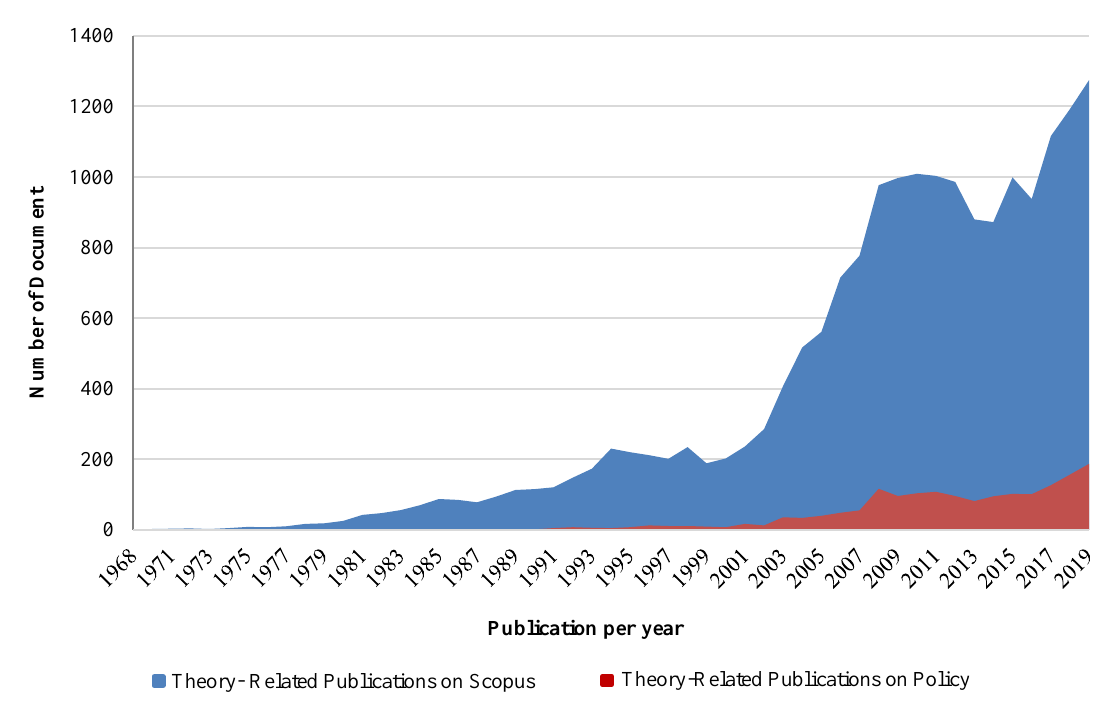
Figure 1. Publication trends in related policy research.